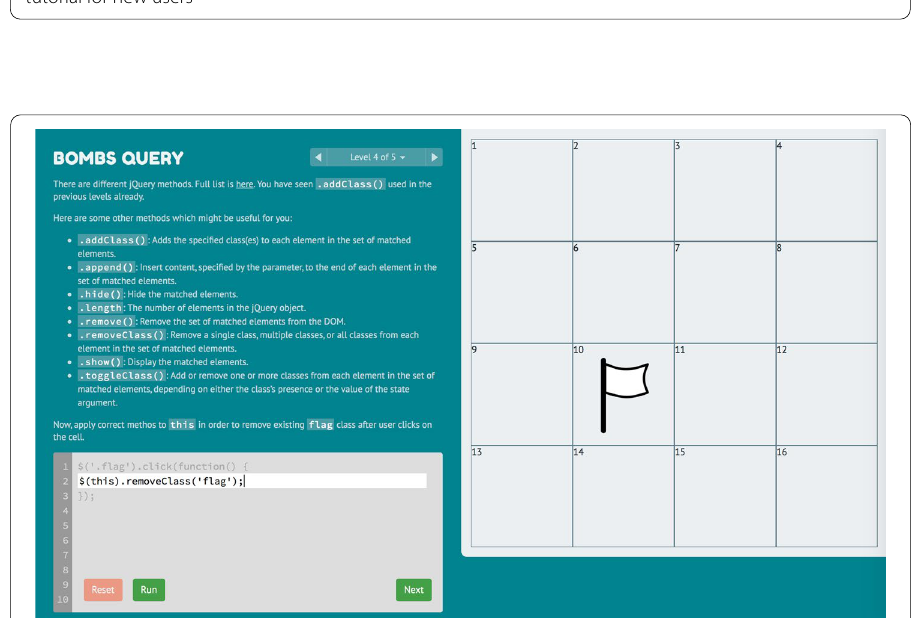
Fig. 2 An example of the mission in the gamified educational system